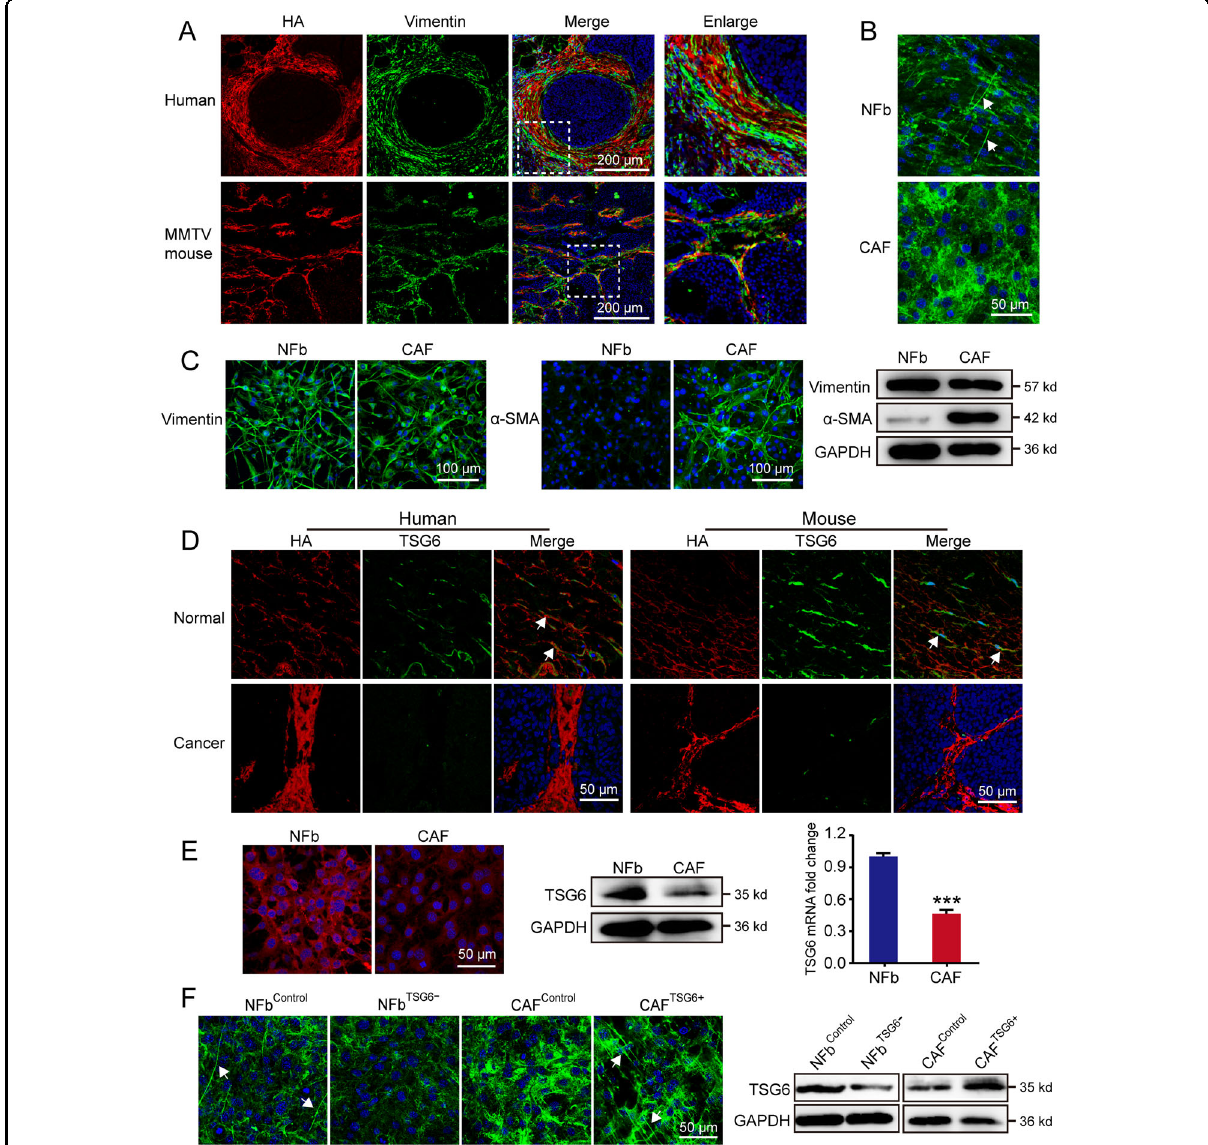
Fig. 2 Cancer-associated fi broblasts were responsible for HA cross-linking de fi ciency in breast cancer. A HA (red) and vimentin (green) staining in breast cancer tissues from patients and MMTV-PyMT mice. HA and vimentin were both mainly localized in the stroma of cancer tissues. Vimentin was expressed within cells, whereas HA was found within and outside of cells. B Normal fi broblasts (NFbs) and cancer-associated fi broblasts (CAFs) were derived from normal breast tissues of FVB mice and breast cancer tissues of MMTV-PyMT mice, respectively. Immuno fl uorescence staining of HA was conducted in NFbs and CAFs. The cable-like structures, as pointed by the white arrows, are the cross-linked HA. C Vimentin and α - SMA were detected in NFbs and CAFs using immuno fl uorescence and western blot. D HA and TSG6 were stained in normal and breast cancer tissues from patients and mice. White arrows point to the co-localization of HA and TSG6. TSG6 was localized within and outside of cells. E The expression levels of TSG6 in NFbs and CAFs were determined by immuno fl uorescence, western blot, and real-time PCR. Error bars show mean ± SD values. Statistical analysis was performed using Student ’ s t test. *** p < 0.001. F NFbs were infected with Lenti-Control or Lenti-shTSG6 viruses (NFb Control and NFb TSG6 − ). Meanwhile, CAFs were infected with Lenti-Control or Lenti-TSG6 viruses (CAF Control and CAF TSG6 + ). The expression levels of TSG6 were con fi rmed by western blot. Then HA was stained to observe HA cross-linking, as indicated by the white